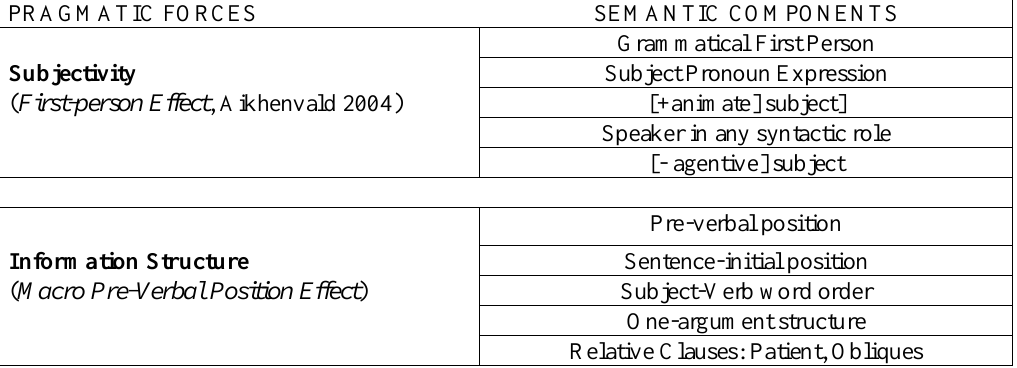
Table 11. Semantic components and pragmatic forces in the grammaticalization of the Evidential Andean Spanish Present Perfect PRAGMATIC